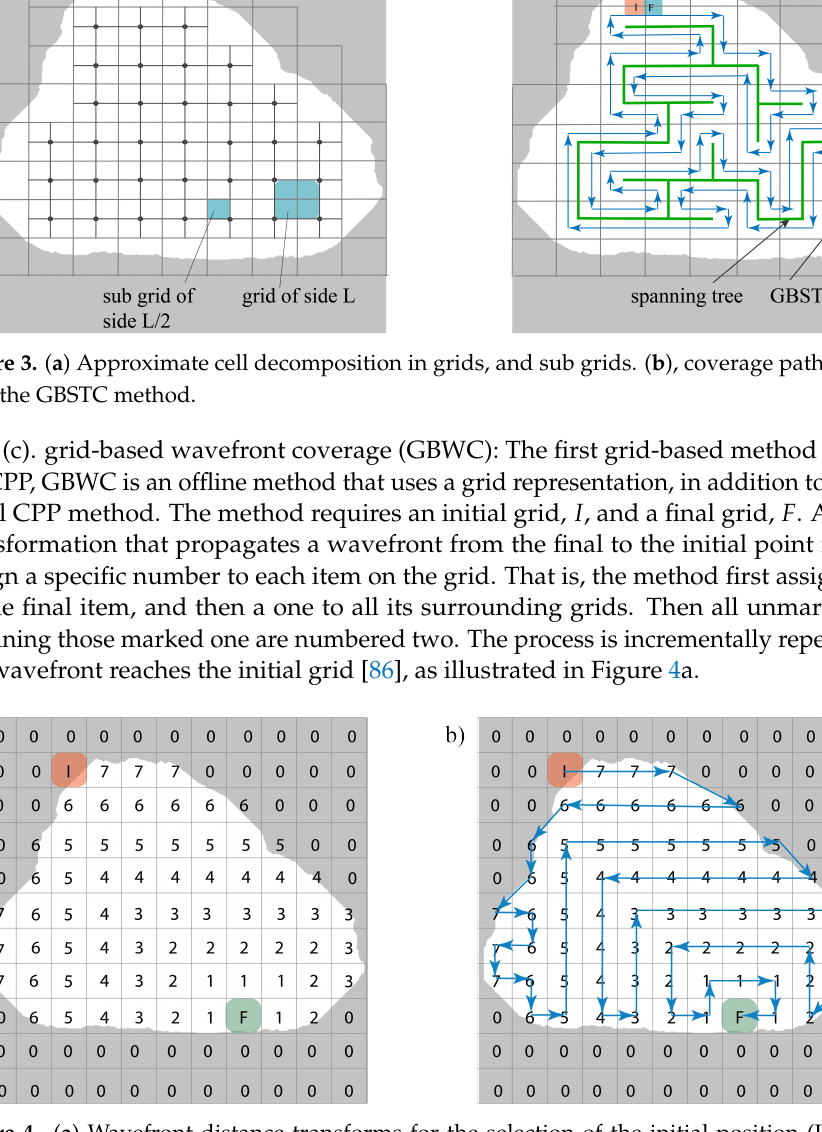
Figure 4. ( a ) Wavefront distance transforms for the selection of the initial position (I) and final position (F). ( b ) Coverage path generated using the wavefront distance transforms with the selection of the initial position